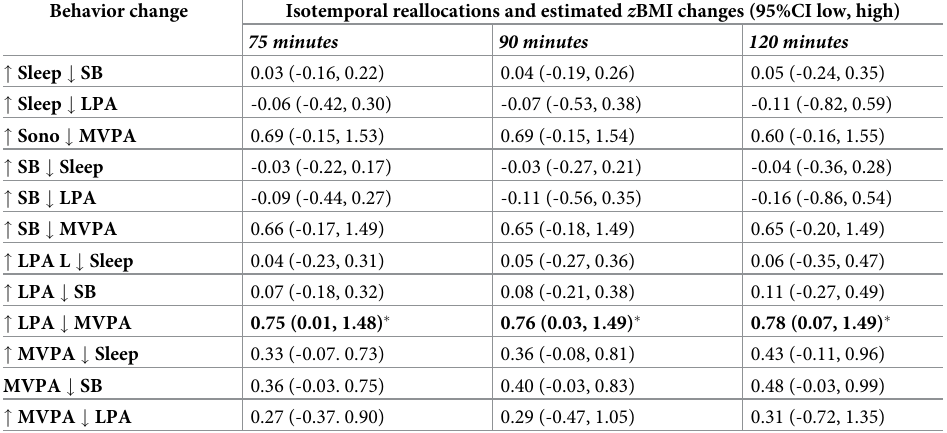
Table 4. Estimated changes in the z BMI associated with the theoretical temporal reallocation between habitual human behaviors. Behavior